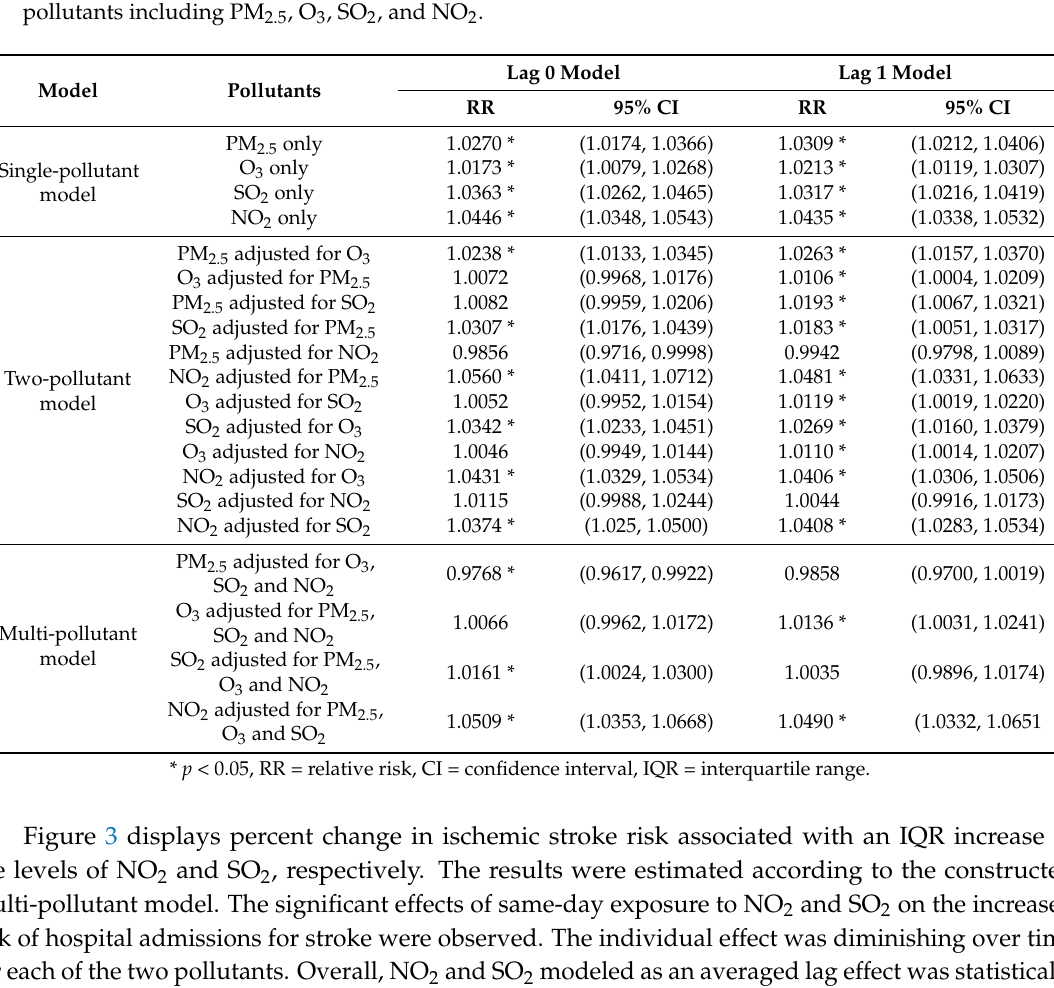
Table 2. Stroke risk ratios associated with an inter quartile range (IQR) increase in the levels of air pollutants including PM 2.5 , O 3 , SO 2 , and NO 2 .